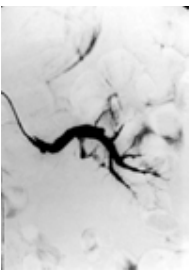
FIGURE 3 . After selective transcatheter embolization, Digital Substraction Angiography demonstrates the occluded branch of the lacerated artery and disappearance of the arterial